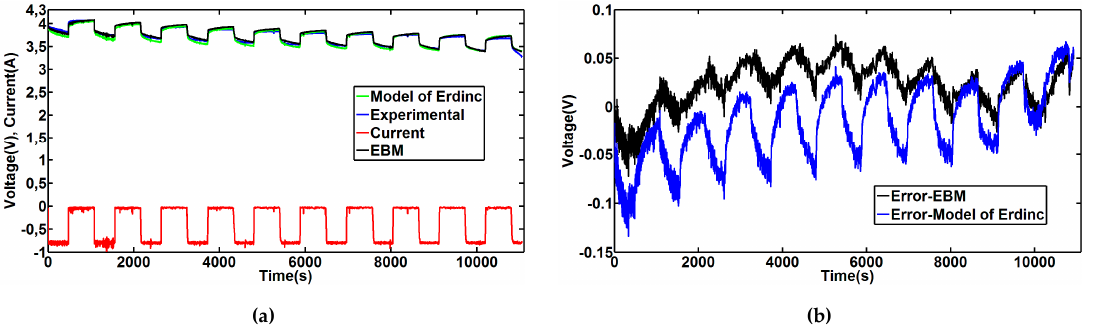
Figure 9. Simulation and experimental curves for 0.8 A current ( a ) voltages and current, ( b ) voltages error.